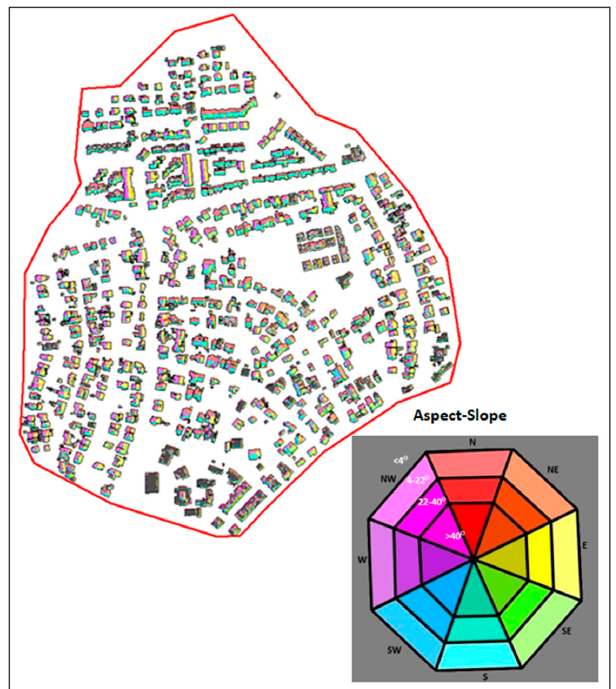
Figure 7. An aspect-slope map.